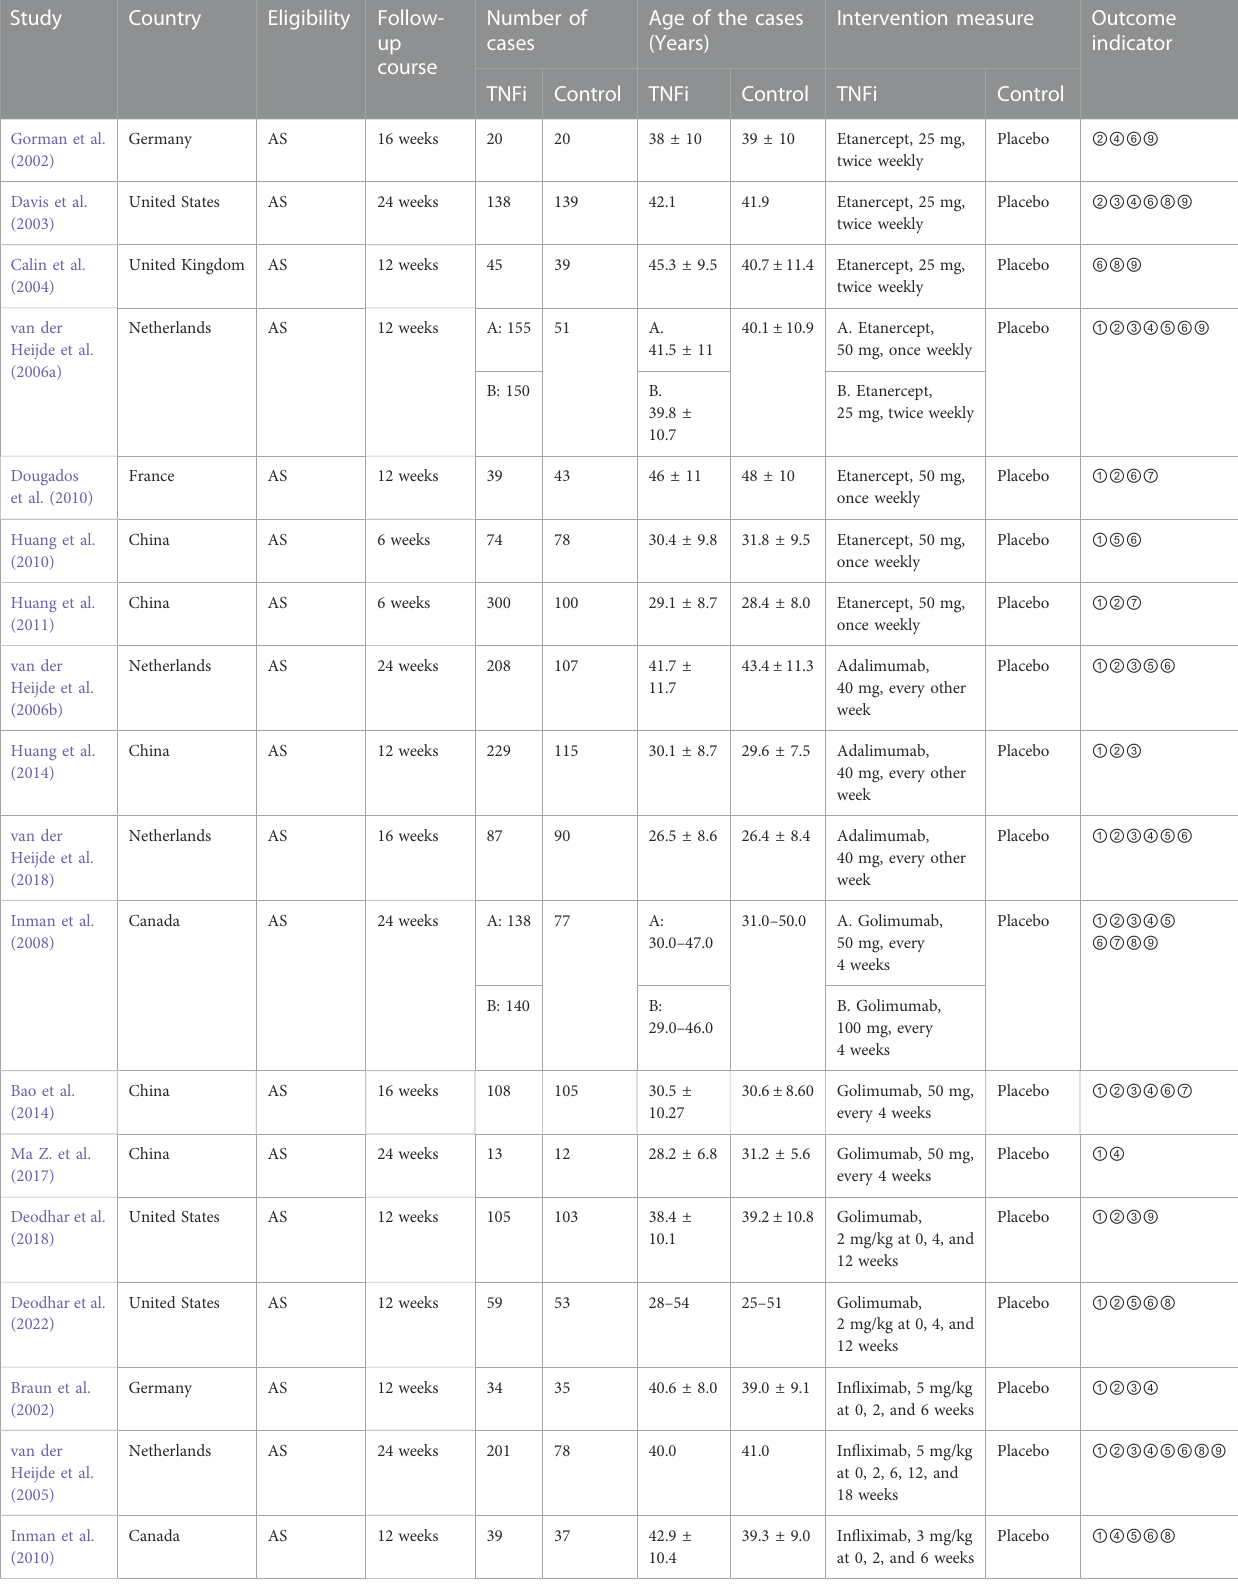
TABLE 1 Characteristics of the included studies in the meta-analysis.